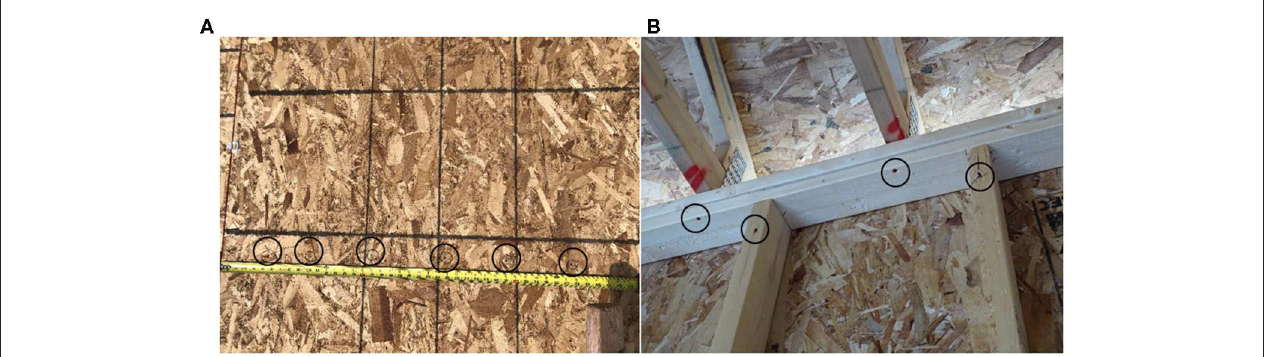
FIGURE 8 | Example inspection photos from the Climate Resiliency Pilot Project showing (A) sheathing nail spacing, and (B) RTWCs using the proprietary screws, as well as screws fastening the wall studs to the top plate. This is an additional measure that is considered best practice for houses that do not have continuous external